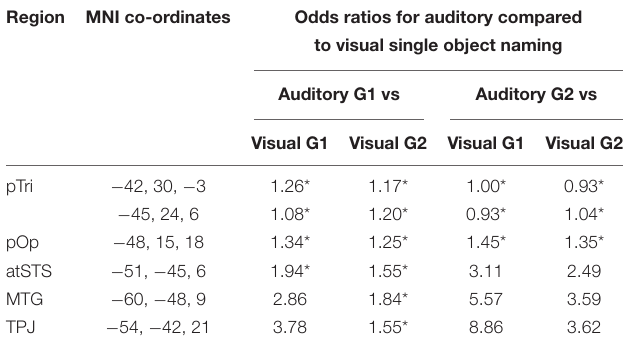
TABLE 3C | Statistical comparison of auditory and visual single object